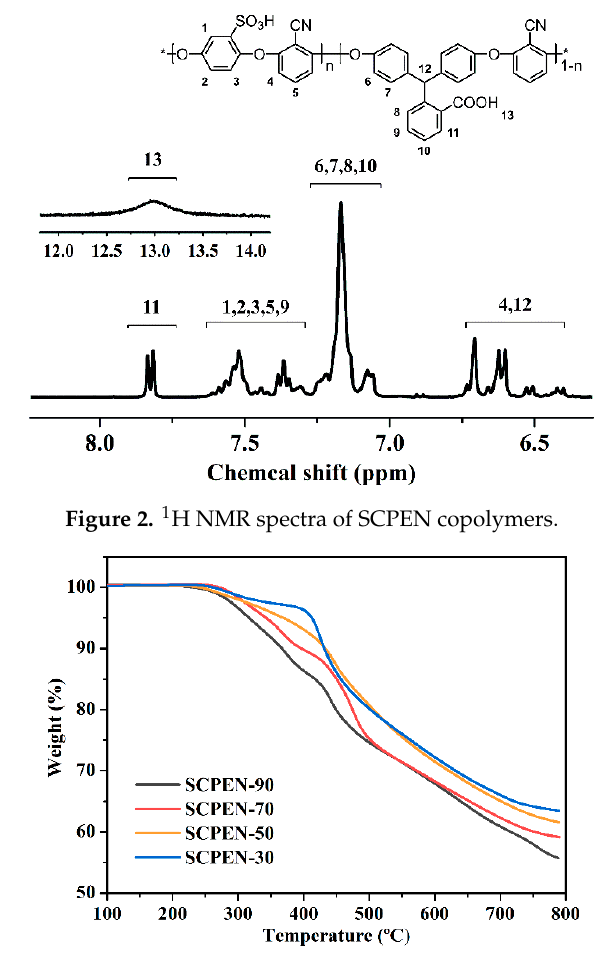
Figure 3. The TGA curves of SCPEN copolymers. Table 2. Thermal properties of SCPENs copolymers.